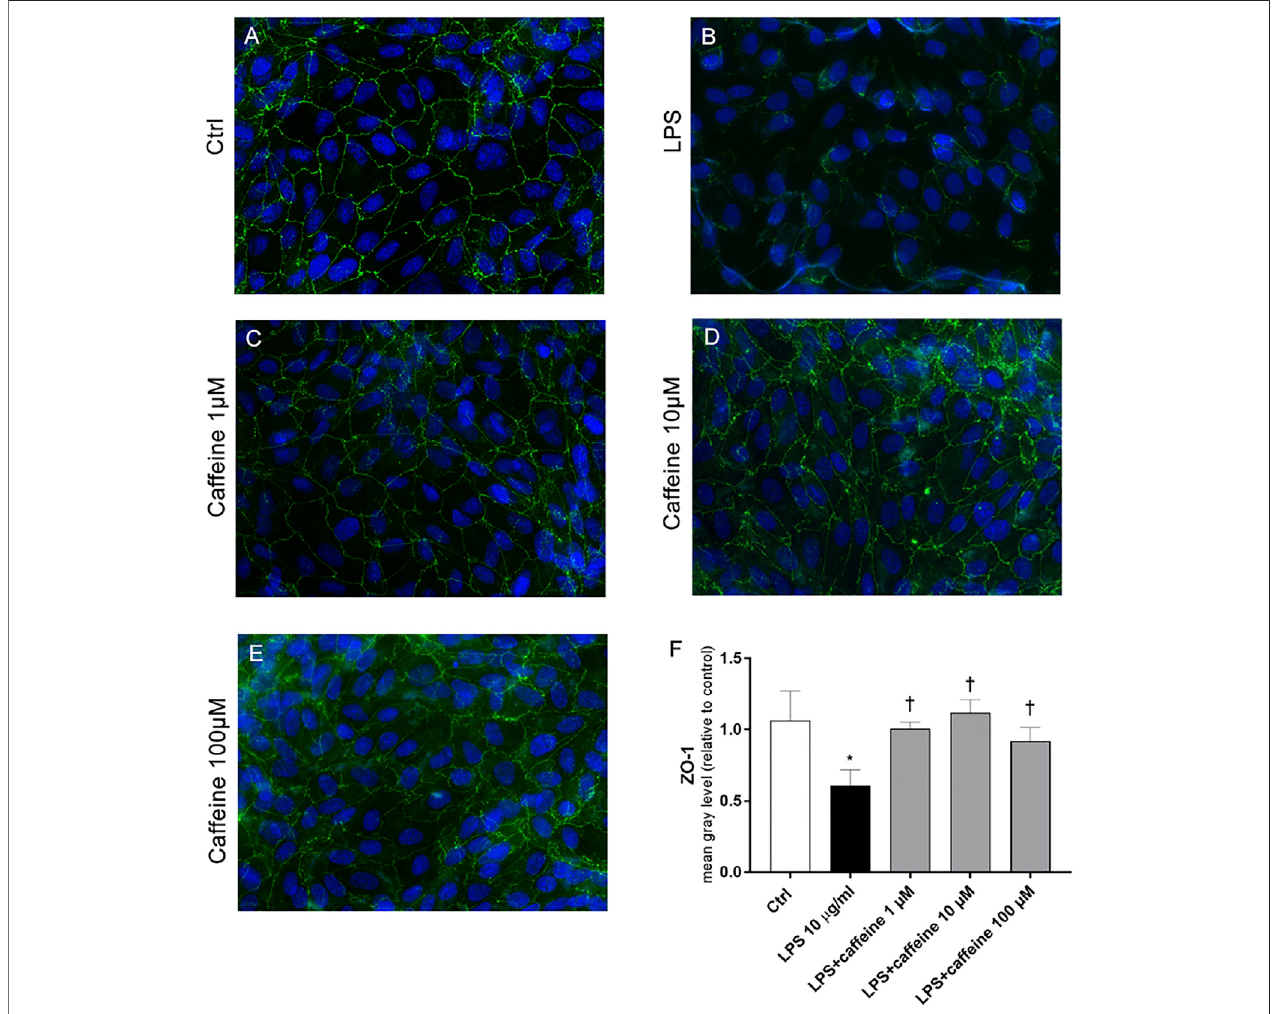
FIGURE 6 | Caffeine re-establishes the BRB integrity through modulation of ZO-1. ARPE-19 were pretreated with caffeine (1 – 10 – 100 µM) for 24 h and subsequently co-treated with LPS (10 μ g/ml) for 72 h. Caffeine, at all concentrations, increased the expression of ZO-1 protein, which was signi fi cantly reduced by LPS (A – E) Representative images for the ZO-1 expression in ARPE-19 after treatment with LPS and caffeine. ZO-1 was labeled with FITC (green); nuclei were labeled with DAPI(blue).Imageswereacquiredat20 × magni fi cation (F) Fluorescencesemi-quanti fi cationofZO-1protein(meangraylevels).Valuesarereportedasmean ± SD; n (cid:1) 4. Data were analyzed by one-way ANOVA and the Tukey post hoc test for multiple comparisons. * p < 0.05 vs. control; † p < 0.05 vs. LPS 10 μ